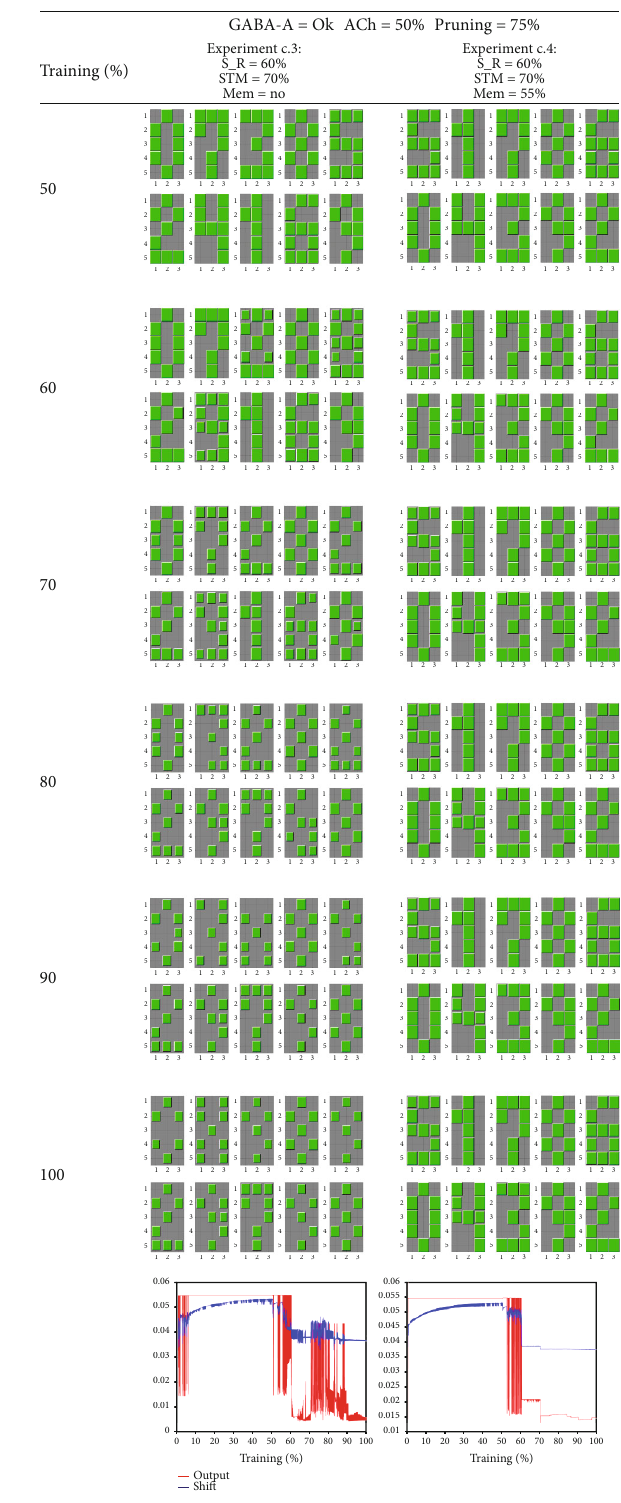
Figure 10: This table shows the koniocortex model response when GABA-A levels are normal, and we reduce ACh at 50% of repetitions. Sensory reduction also takes place at 60% of total repetitions, and a memory test is performed at 70%. Experiment c.3: an NMDA blocker (like memantine) is not used. Oscillations are present initially when ACh is reduced and, especially afterward, during the process of learning the new pattern X. Experiment c.4: an NMDA blocker (like memantine) is applied at 55% of epochs. In this case, plasticity is eliminated; the network remains at its former stability level (without oscillatory activity) although it is not able to learn the testing pattern X. Labels: S_R=sensory reduction; STM=short-term memory; Mem=memantine; ACh=acetylcholine reduction in thalamocortical